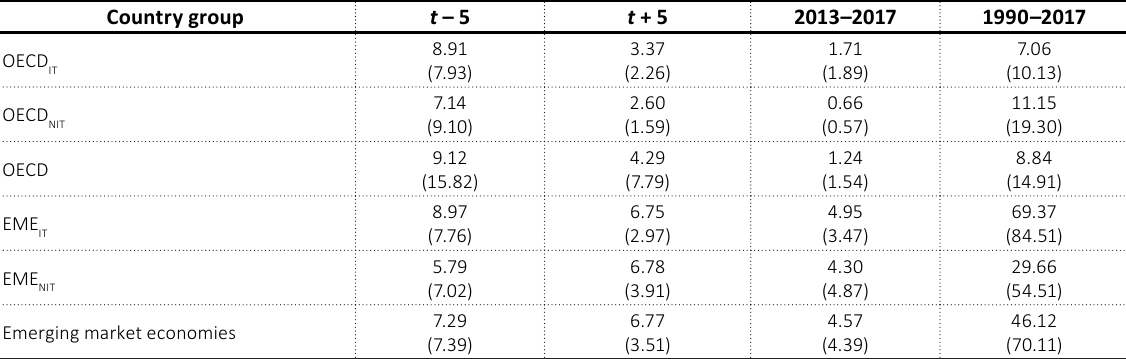
Table 2. Consumer inflation in OECD and emerging market economies,